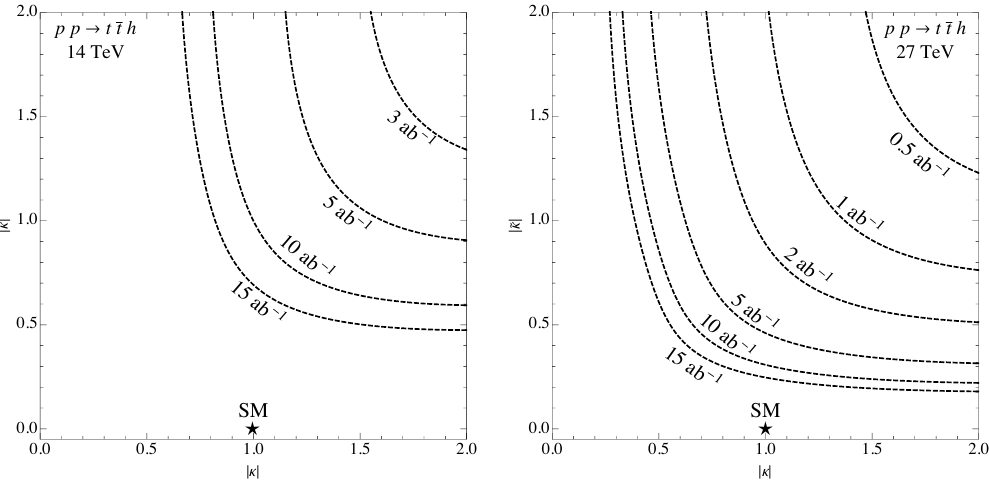
Figure 7 . The expected 2 (cid:27) exclusion regions for measuring a null result of O 6 (3.8) are shown for di(cid:11)erent luminosities at HL-LHC (left) and HE-LHC (right).